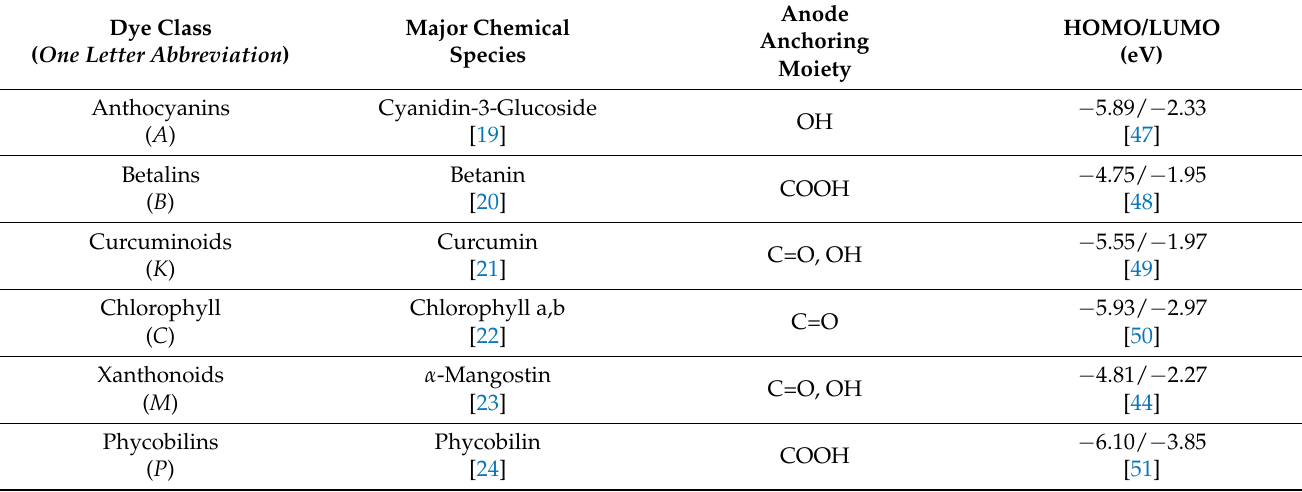
Table A1. Miscellaneous dye information including the prevalent anode anchoring moiety, HOMO/LUMO levels referenced against vacuum level and the formal redox potential using a standard Ag/AgCl